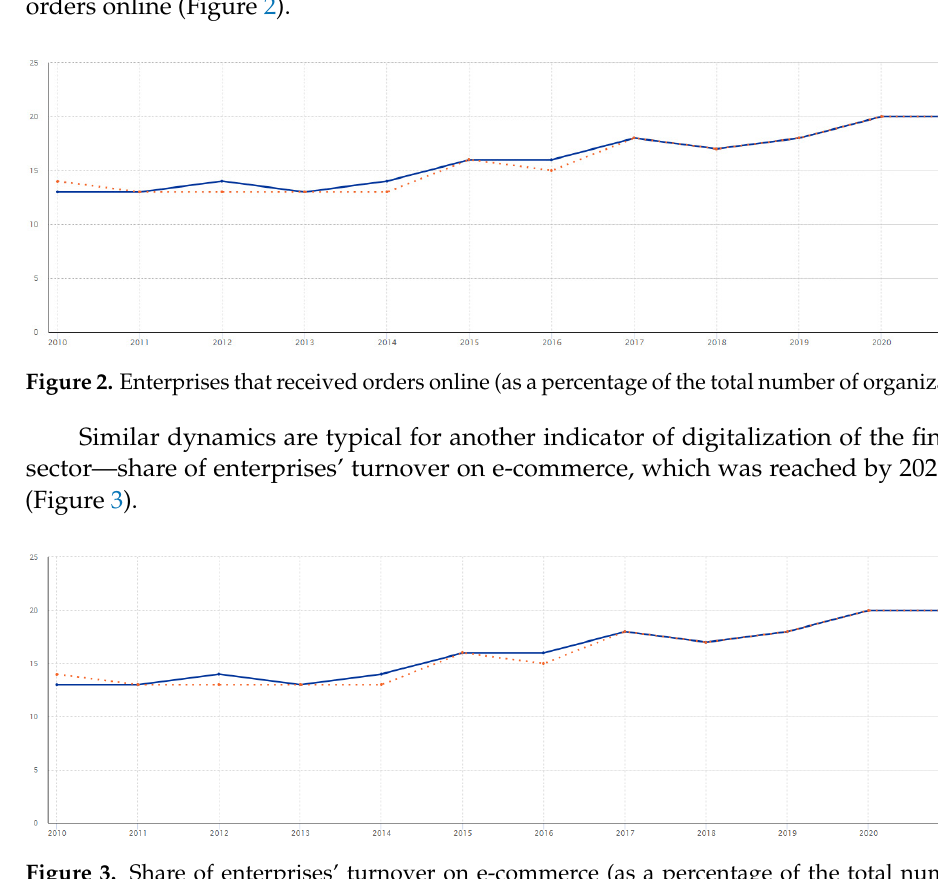
Table 3. Regression analysis results for variable Y1.